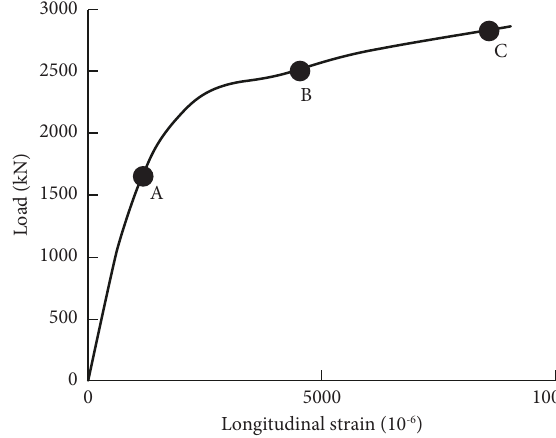
Figure 7: Load and strain curve.